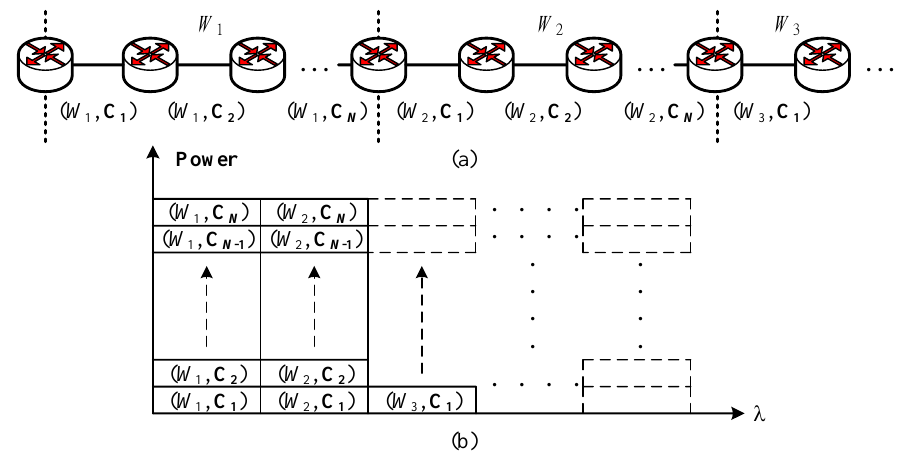
Figure 3. Sequential code distribution: ( a ) label assignment to the label switched path (LSP), ( b ) power spectral density (PSD) of the stacked labels.